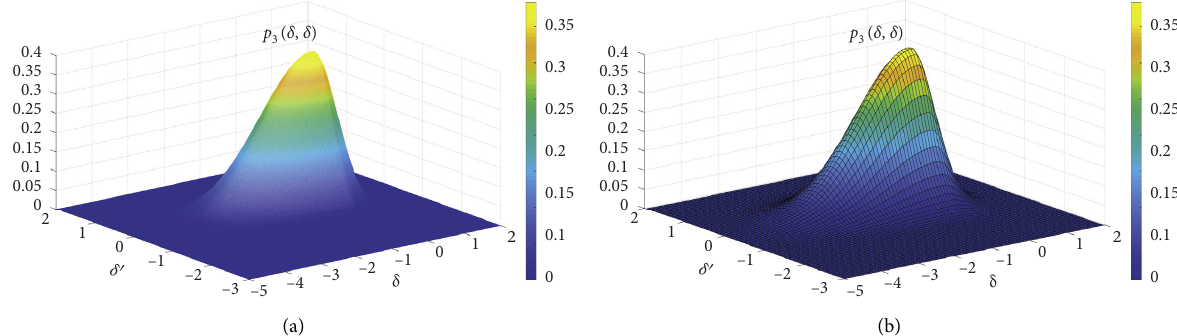
Figure 14: Comparison of displacement and velocity united PDF of ATHNPO. (a) Theoretical solution. (b) Numerical